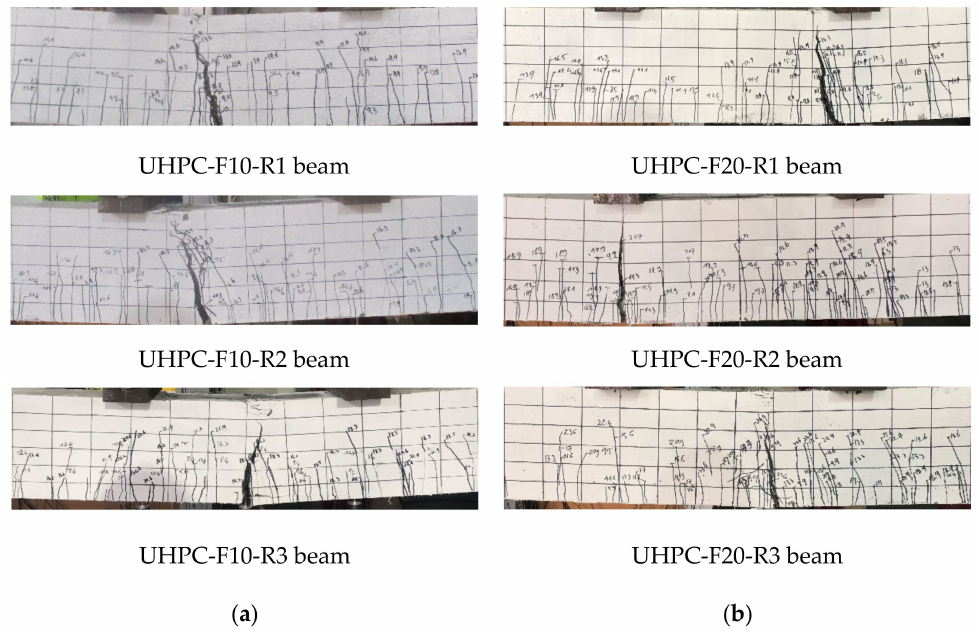
Figure 10. Typical failures of the UHPC beams. ( a ) 1.0% steel fiber content, ( b ) 2.0% steel fiber content.